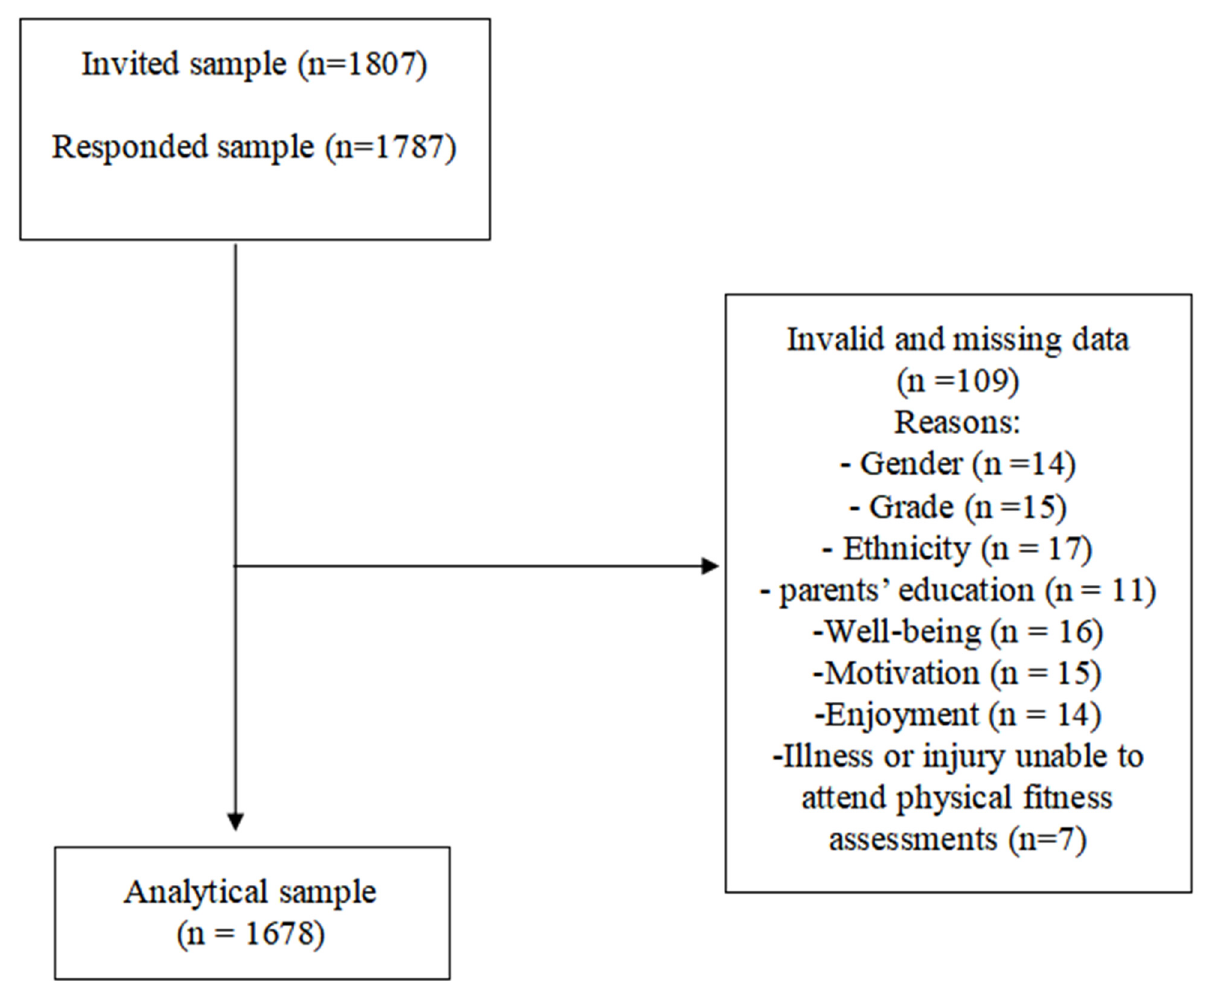
Figure 1. The procedure used for cleaning invalid and missing data in this